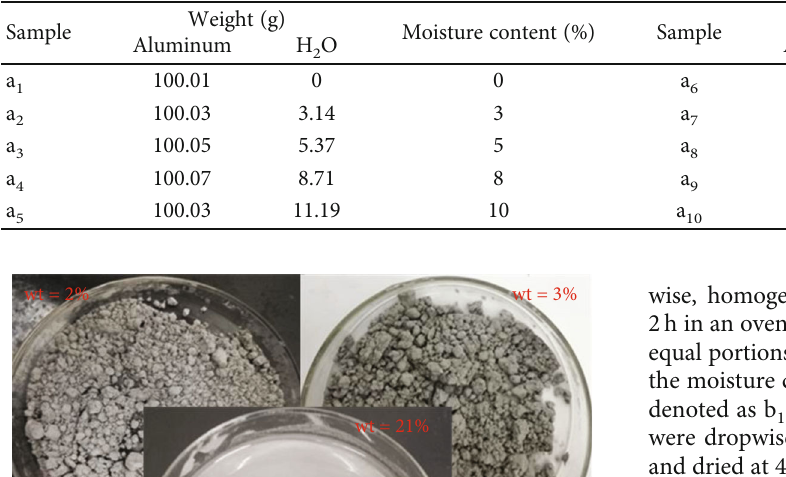
Figure 2: SEM images of aluminum powder. Table 2: Compositions of aluminum powder samples with di ff erent moisture contents prepared from sample a.